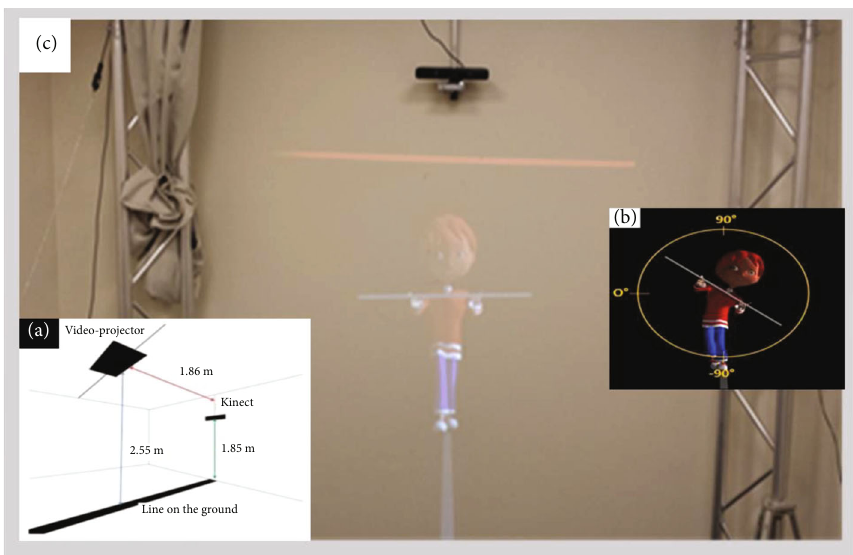
Figure 1: Principles and setup of the experiment. (a) Schematic illustration of the experimental room with the projection on the wall of the tightrope walker avatar. (b) Tightrope walker avatar ’ s head and bar inclinations in the front-facing